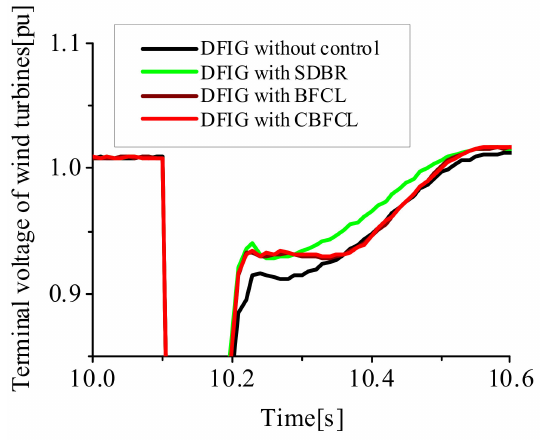
Figure 23. Terminal voltage of DFIG wind turbine